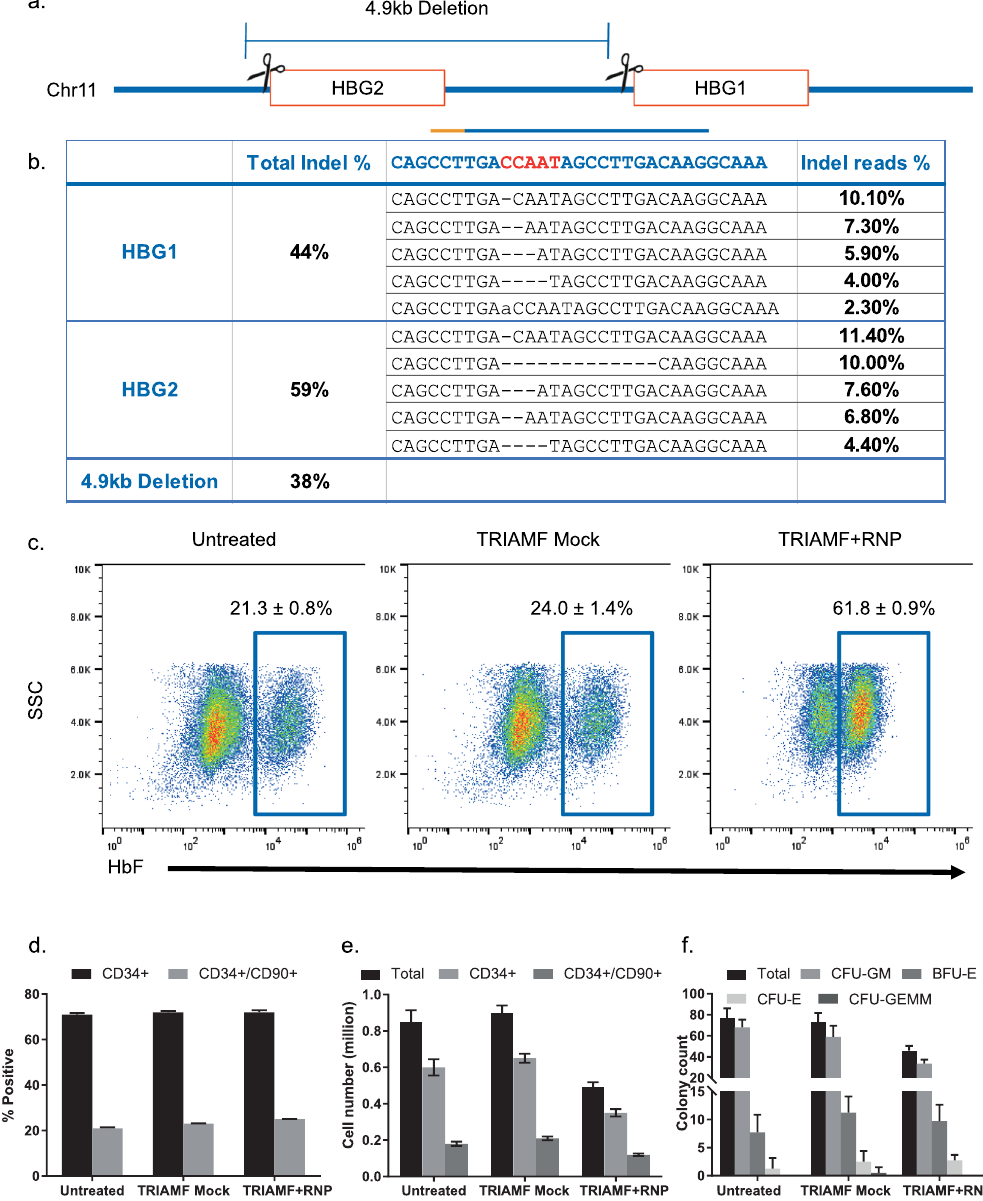
Figure 2. Genome editing of the HBG1 and HBG2 promoters using TRIAMF mediated delivery of RNPs. ( a ) HBG1 and HBG2 promoter and g1-RNP cutting sites. ( b ) The sequence of HBG1 and HBG2 target sites, the bar indicates targeting gRNA-1 with orange indicating the PAM site. The putative transcription repressor binding CCAAT box sequence is marked in red. Total indel percentages among total reads by NGS with top 5 frequent alleles. The 4.9 kb deletion between the two target sites as detected by qPCR. (n = 2, single donor, biological duplicate, indel patterns are mean of biological duplicates). ( c ) Representative flow cytometry plots showing HbF + immunostaining of CD235a + /CD71 − /low cells after erythroid differentiation for 3 weeks of untreated, mock treated (TRIAMF Mock), and g1-RNP edited (TRIAMF + RNP) HSPCs (see Fig. S5 for gating strategy). ( d ) Immunostaining of HSPCs for CD34 and CD90 markers after 7 day expansion post treatment. ( e ) Cell count of CD34 + and CD34 + /CD90 + cells after 7-day expansion post treatment. ( f ) Colony forming unit assay. Numbers indicate mean + / − SD, n = 4 (single donor, biological duplicate with technical duplicate